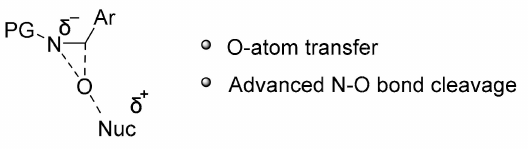
Figure 2. Asynchronous transition state for oxygen atom transfer reaction